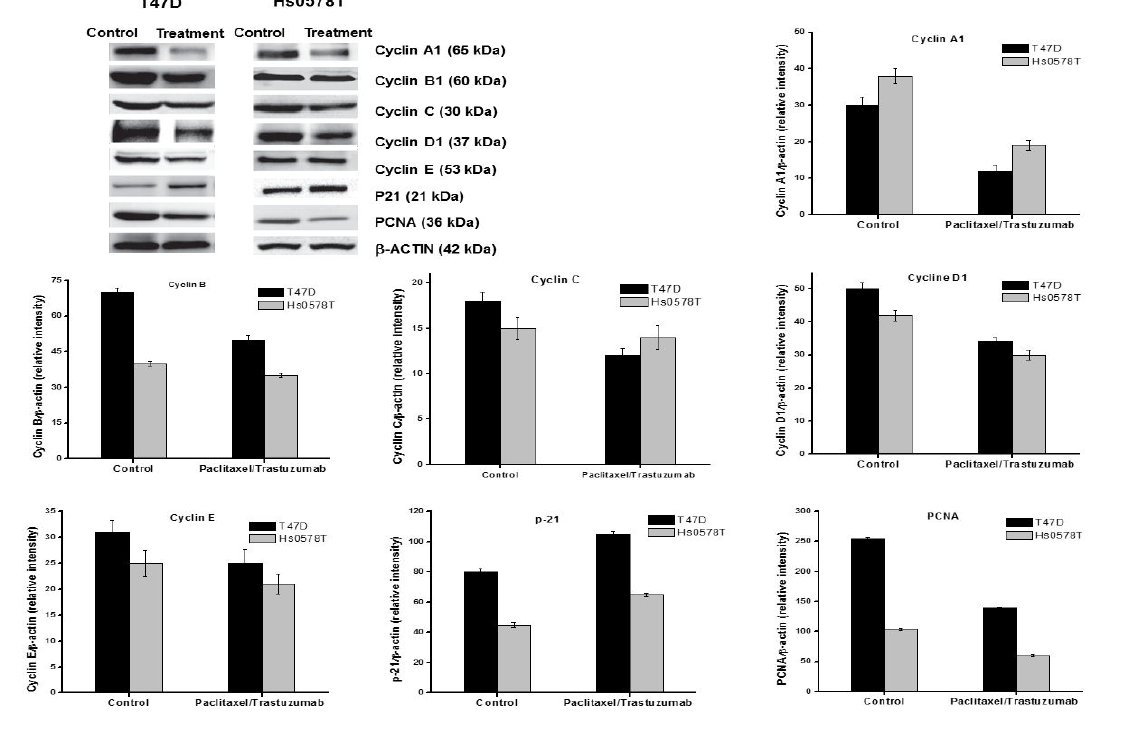
Figure 6: The expression of cyclins in paclitaxel and trastuzumab treated breast cancer cell lines analyzed by